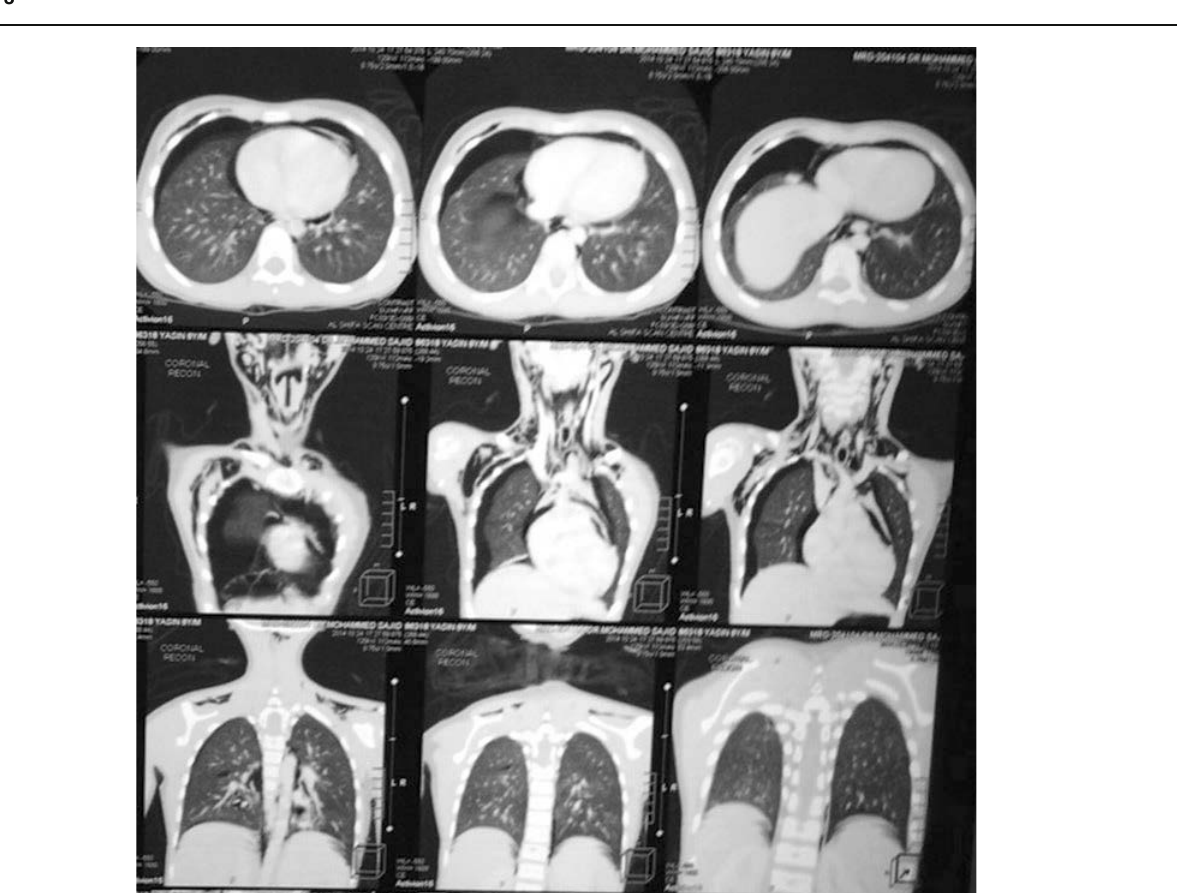
Computed tomography showing pneumothorax and pneumomediastinum.